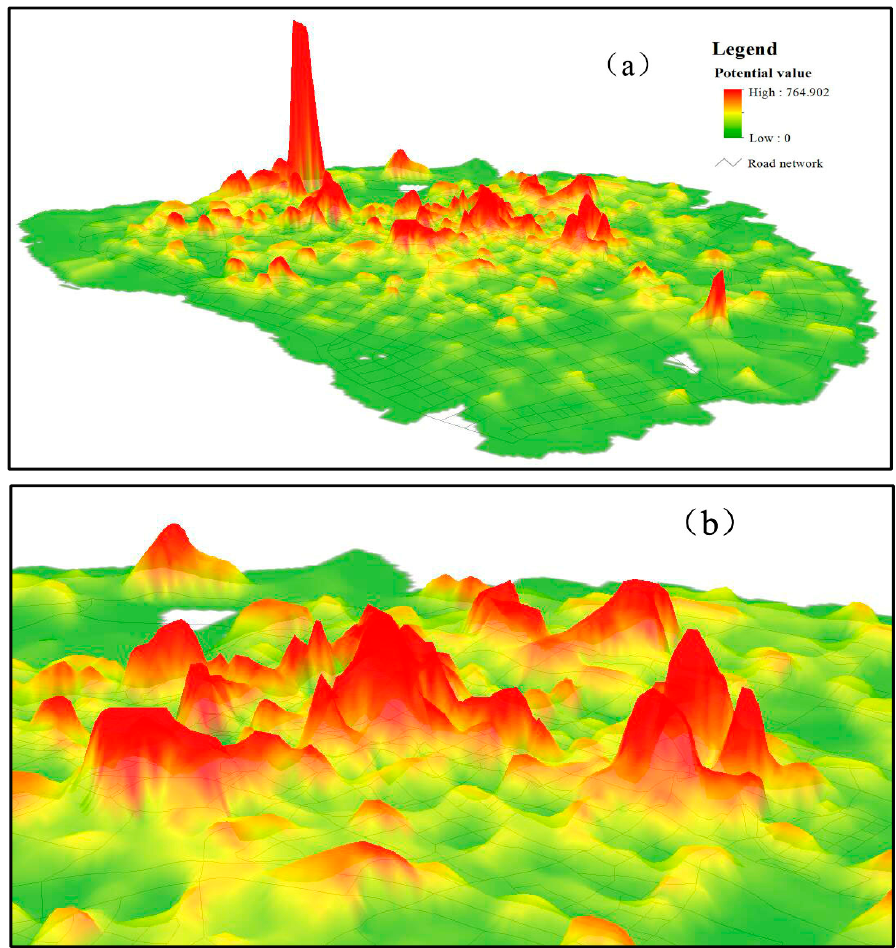
Figure 8. Three-dimensional visualization of the potential intensity surface of hotspots in ( a ) the whole study area and ( b ) a local region.